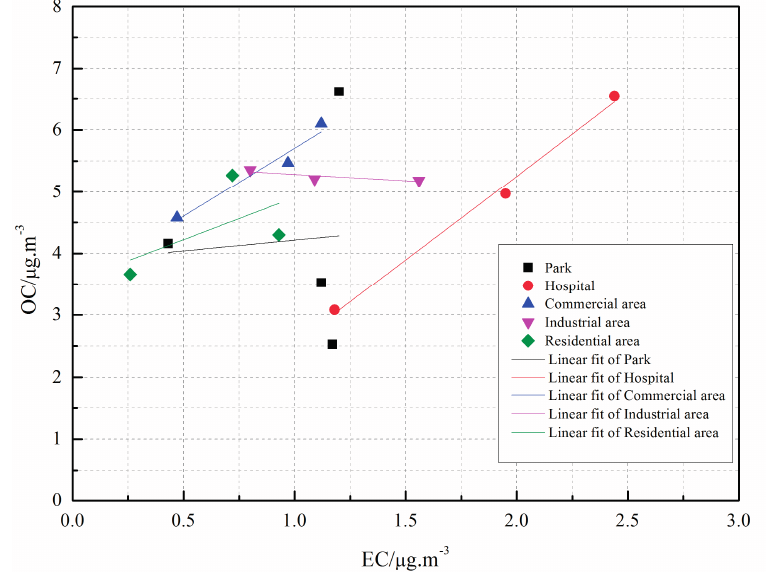
Figure 4. Correlation between EC and OC in PM 2.5 for the different functional areas of Xiamen during the summer study period; the Adj. R 2 of Parks, Hospitals, Commercial areas, Industrial areas and Residential areas were − 0.49, 0.99, 0.92, 0.45, − 0.32 and − 0.49,